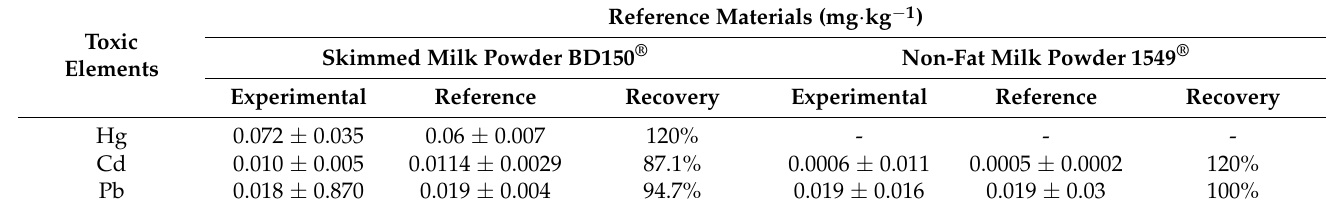
Table 2. Toxic metals determination in reference materials and recovery values (%) for each mineral relative to the reference concentration